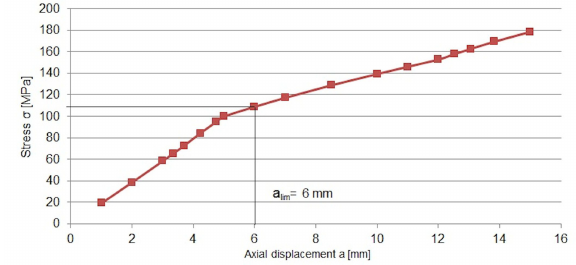
Figure 15: The von Misses stress in reinforcing layer depending on axial tensile displacement and internal pressure 25 bar for elastic diaphragm made of EPDM